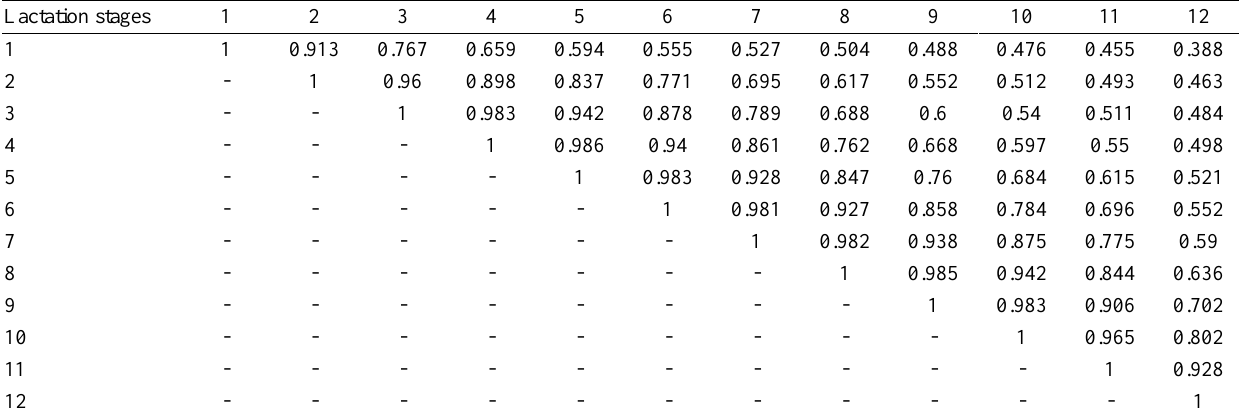
Table 5. Permanent environmental correlations between test-day protein yield at different stages of lactation Lactation